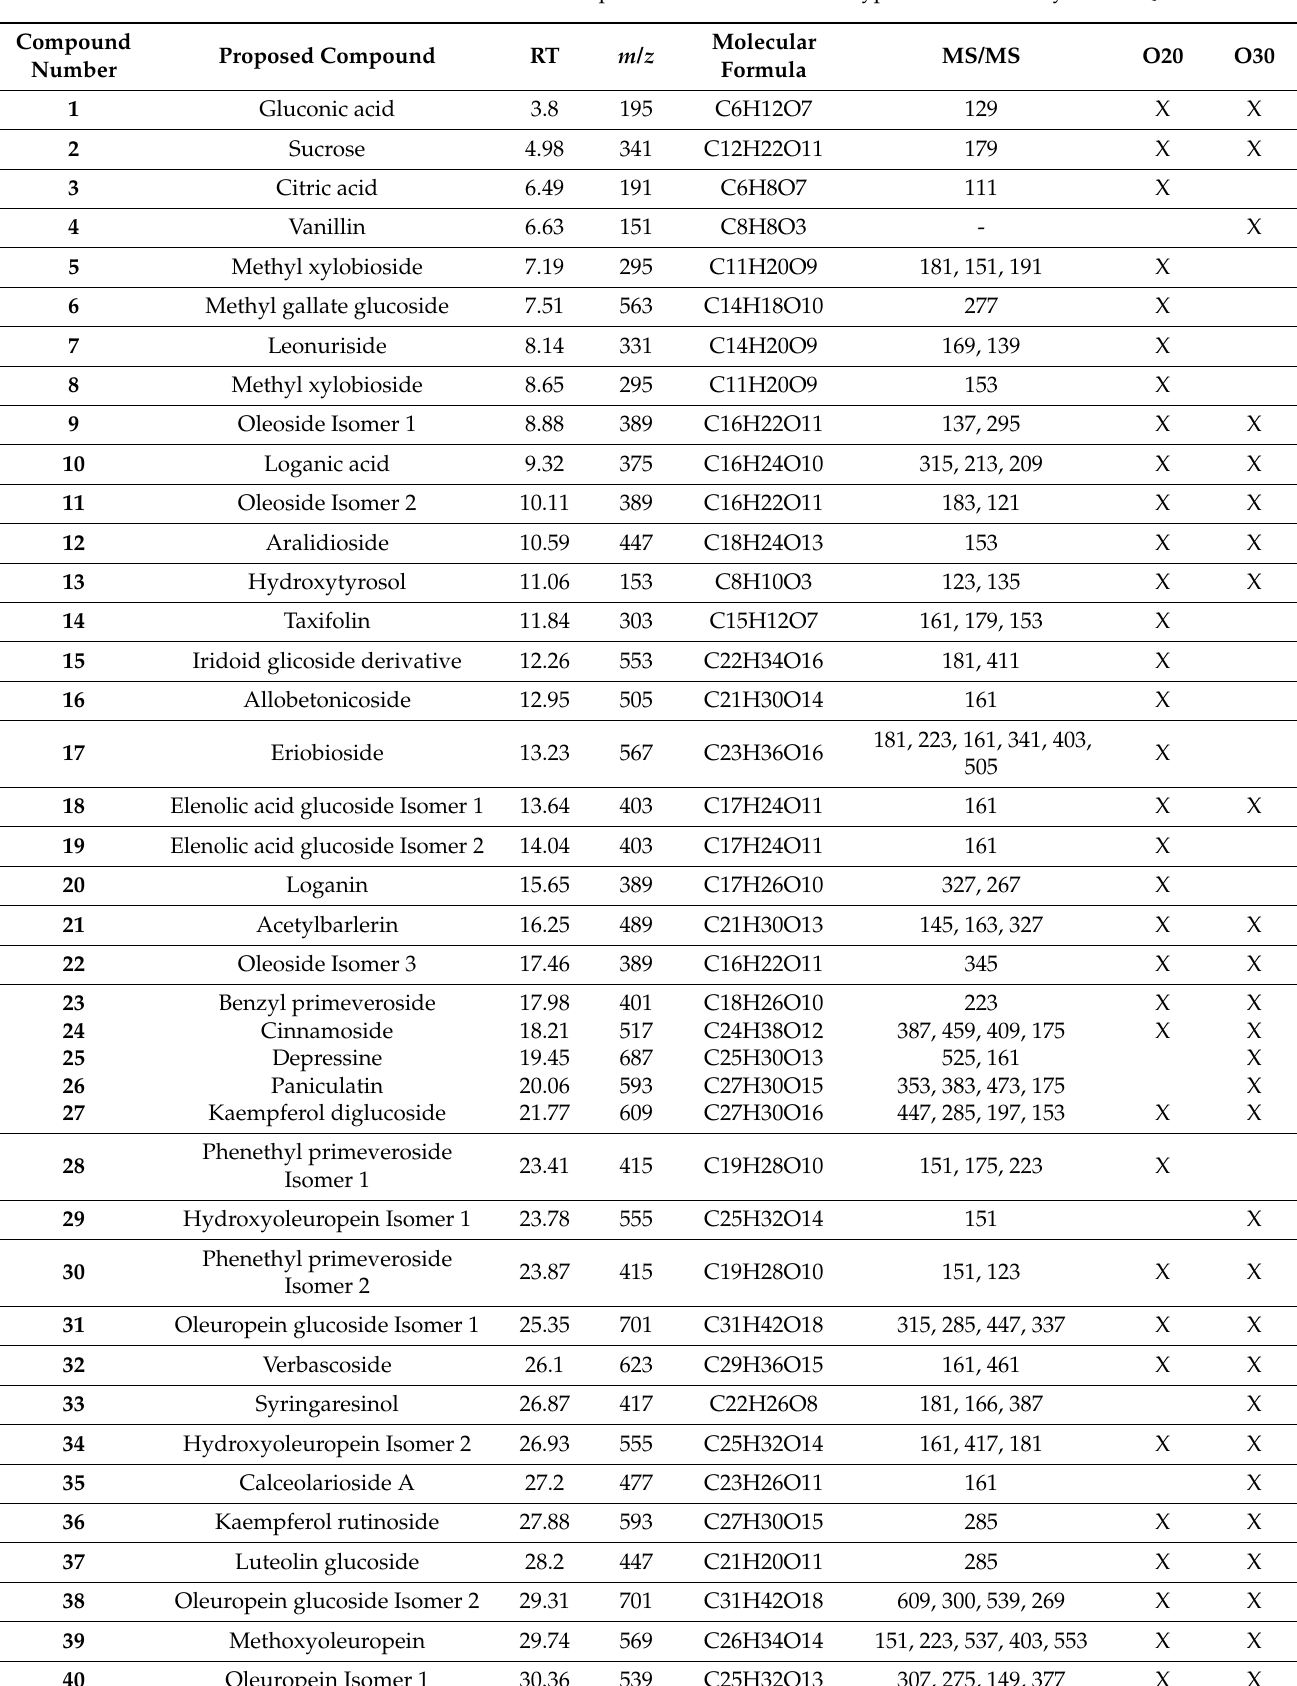
Table 1. Chemical characterization of bioactive compounds detected in olive byproduct extracts by HPLC-QTOF.